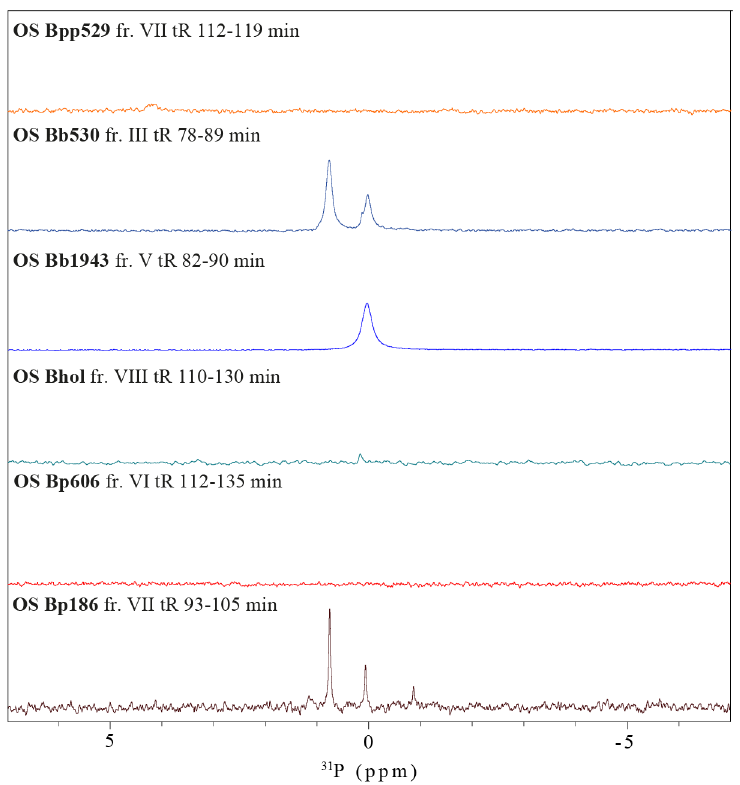
Figure 5. 31 P NMR spectra of the main core oligosaccharides of Bordetellae LPS. The combined NMR data allowed for the identification of the least variable segment, conserved among all the investigated Bordetellae , and indicated core-related sources of structural variation. The innermost hexasaccharide, comprising the residues E , H / I , J , B , F , and the Kdo, is the “lowest common denominator” structure conserved among all the investigated core oligosaccharides of Bordetellae . (Figure 6).